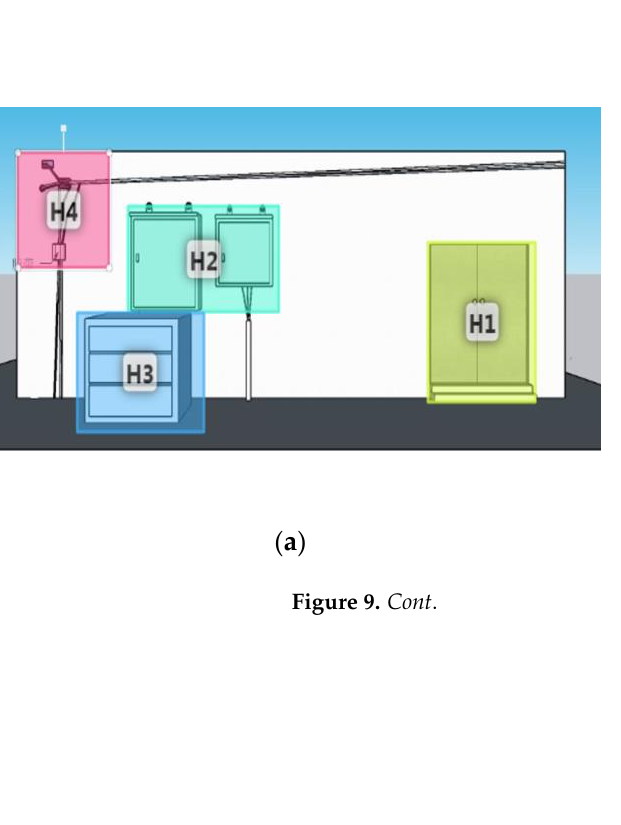
Figure 8. Comparison chart of hazard recognition data for three groups of workers. ( a ) Comparison of hazards recognition accuracy and missed detection rate of workers. ( b ) Comparison of the search duration and mean fixation duration of the workers’ hazard search.